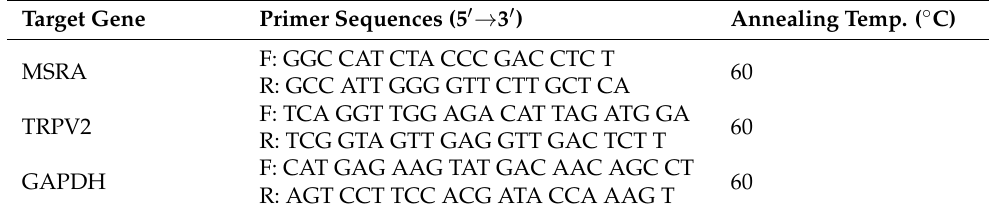
Table 3. Primers used for quantitative polymerase chain reaction